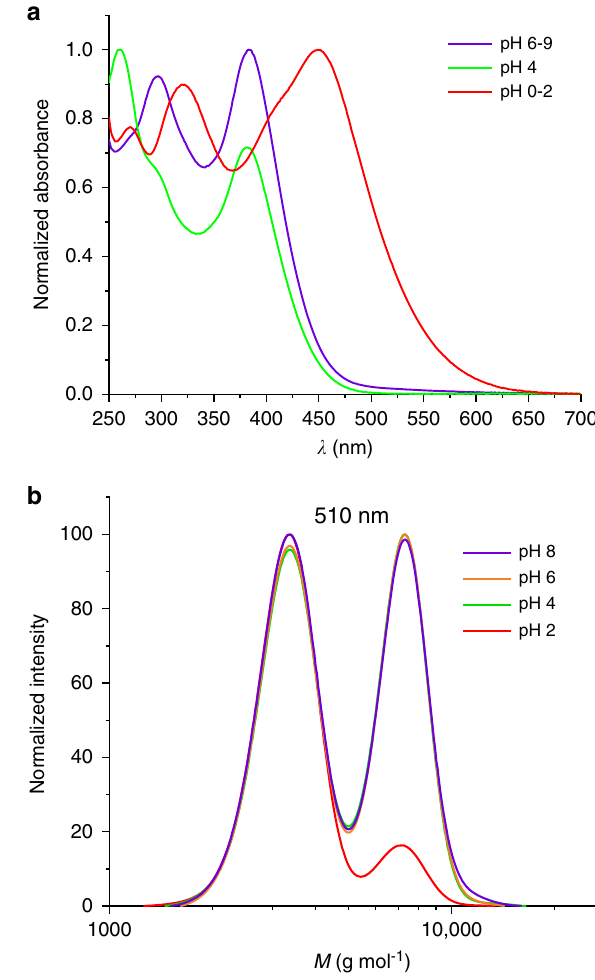
Fig. 4 pH-dependent reactivity studies. a UV/vis spectra of PEG-SQ solutions at different pH values. b SEC data of PEG-SQ solutions (10mgmL − 1 ) in water with different pH after irradiation at 510nm with the same number of photons (1.23×10 22